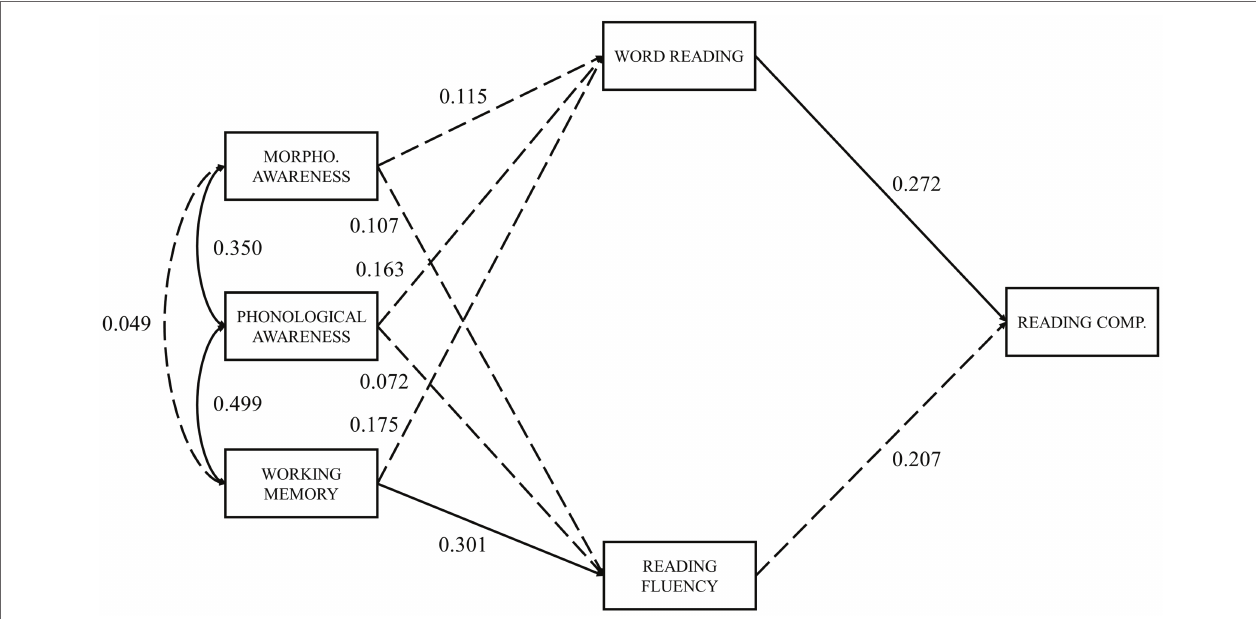
FIGURE 5 | Full mediation by word reading and reading fluency model, with Standardized path coefficients. χ 2 (4) = 15.641, p = 0.004; CFI = 0.800; RMSEA = 0.210. Dashed lines represent non-significant paths; solid lines represent significant paths ( p <